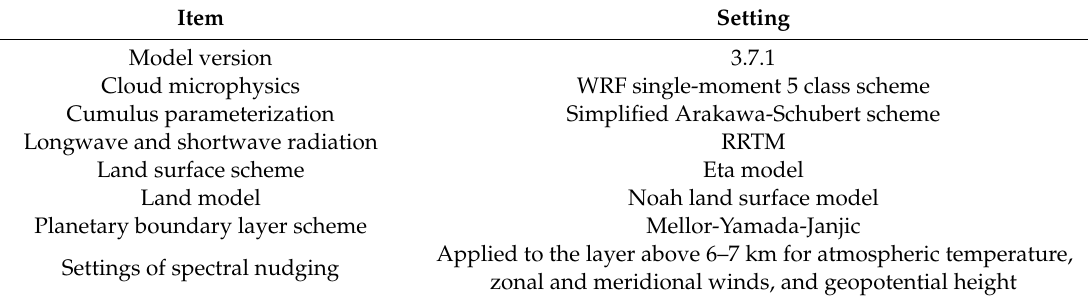
Figure 1. Target domains for the weather research and forecasting (WRF) simulations. ( a ) Parent domain; ( b ) intermediate domain; ( c ) child domain. The blue, red, and yellow areas represent the parent, intermediate, and child domains, respectively. The red line and open rectangle shown in ( c ) indicate the Kanto area and area A, respectively. The red circle in ( c ) is the location of Nikko city. Table 2. Settings of the weather research and forecasting (WRF)